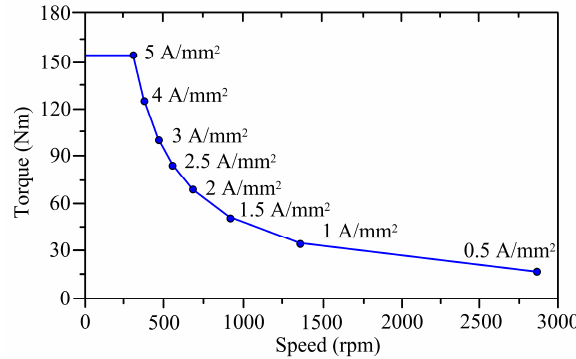
Figure 13. Torque-speed characteristics of the proposed